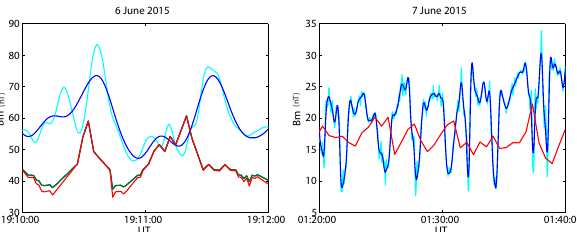
Figure 11. Left panel: three 20min intervals of the magnetic field strength B m data, shifted to enhance visibility – blue 01:20– 01:40UT, green 02:20–20:40UT, red 03:20–03:40UT. The grey stars show the LAP P1 current. Right panel: the Fourier power spec- tra for the three intervals. The coloured arrows at the top mark the peaks discussed in the